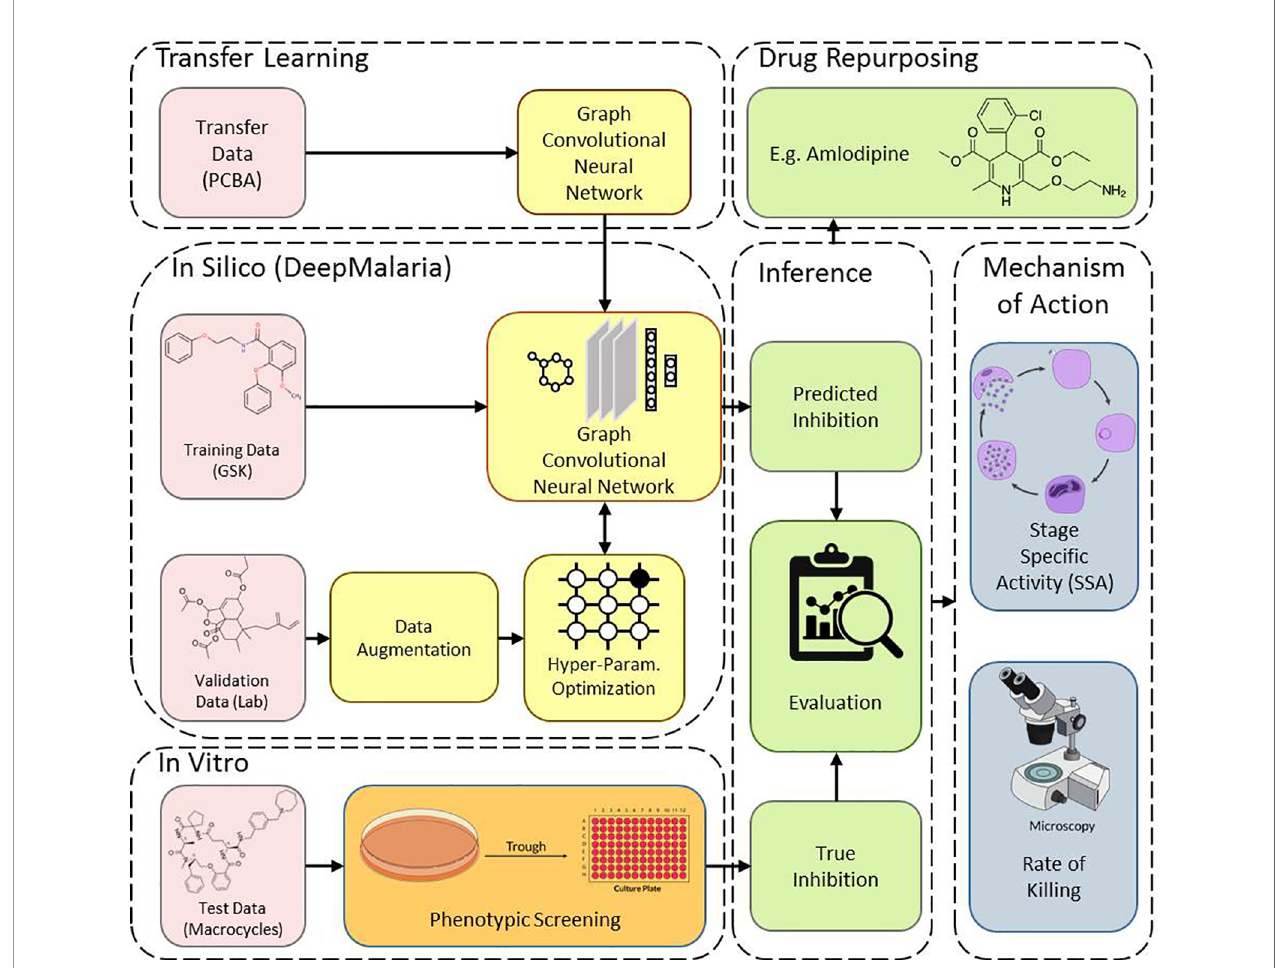
FIGURE 1 | Overview of Transilico architecture used to train DeepMalaria . In silico , the validation dataset is augmented and is used to determine the hyper- parameters of the model. The model is pre-trained on the transfer dataset and fi ne-tuned on the training dataset. In vitro , the test compounds are tested on Pf . The results are compared to predictions. The trained model can be applied for drug repurposing. The mechanism of action for the hits are determined.